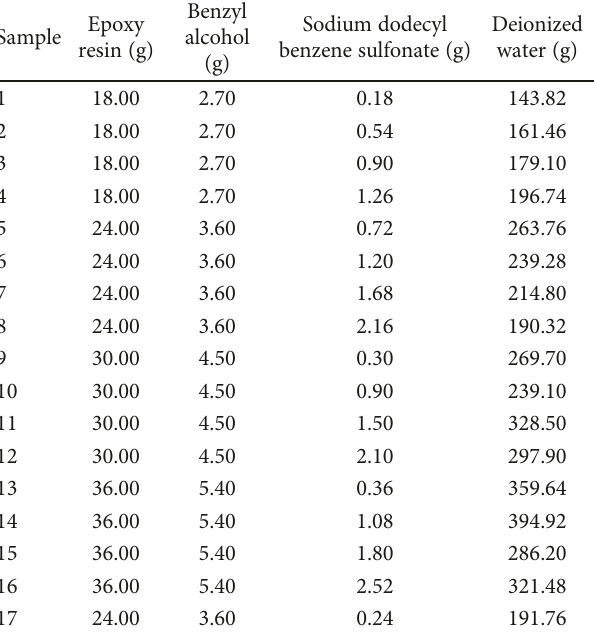
Table 3: Detailed list of amounts of materials.